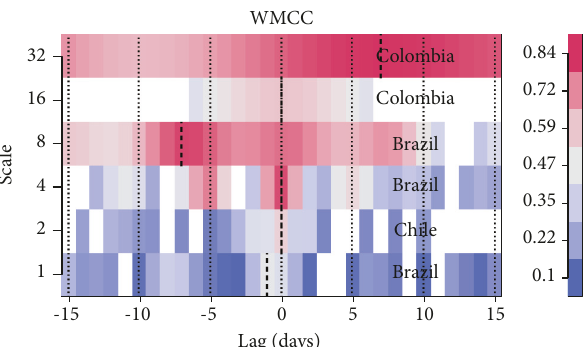
Figure 7: Wavelet multiple cross correlation between systematic risk of Americas (18/08/2010–03/11/2020).